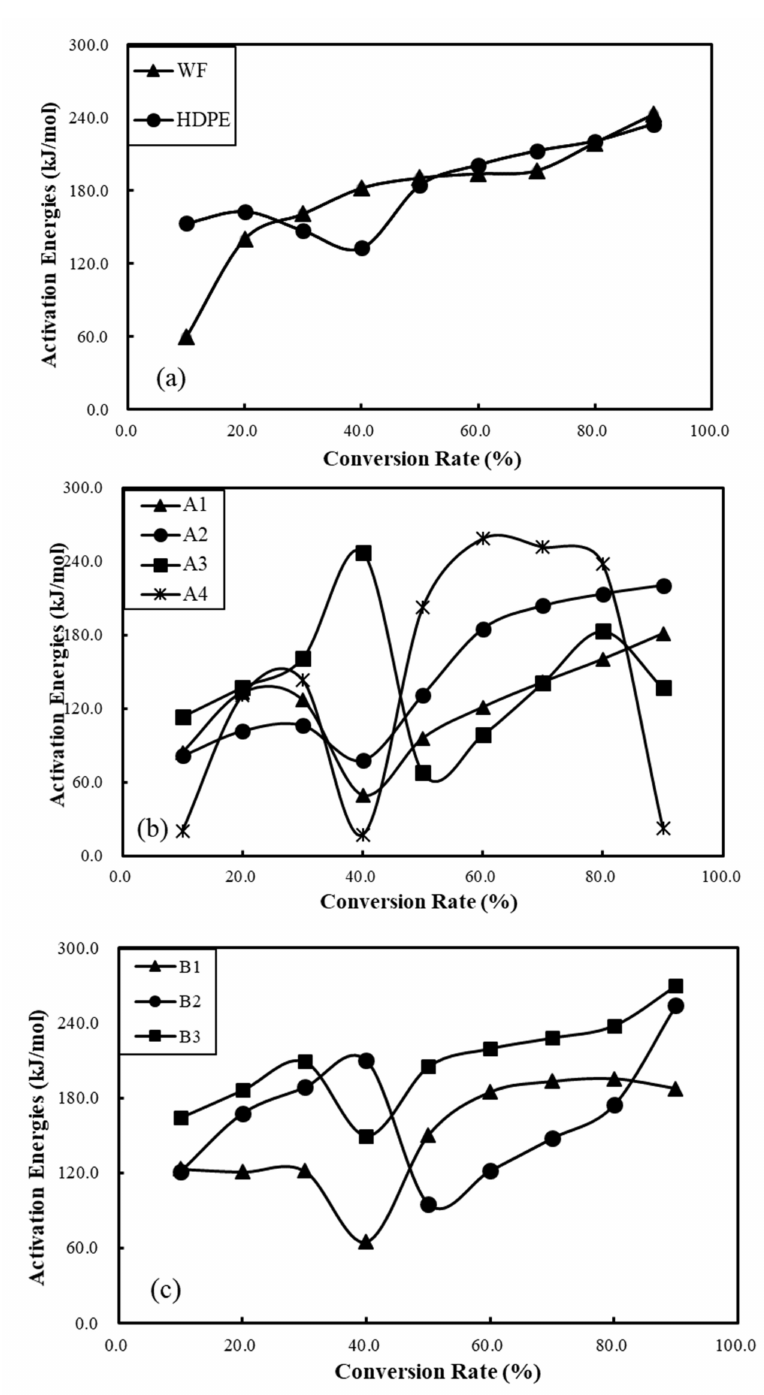
Figure 6. E ff ects of conversion rate on activation energy changes of raw materials ( a ), WPCs ( b ), and WPCs reinforced with BFs ( c